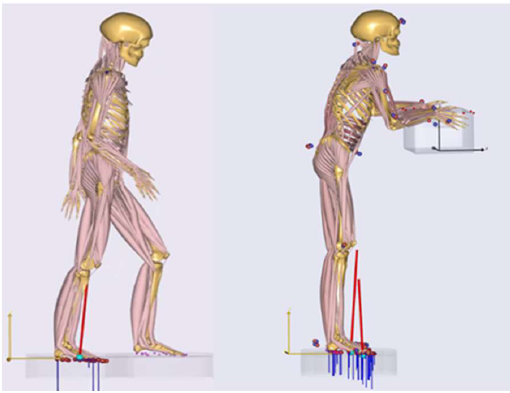
Figure 4. Musculoskeletal models in high loaded static postures with visualization of muscle activation (left: pushing, middle: pulling and right: lifting), the models are shown with external body forces as red arrows in the representative posture for the three application scenarios.